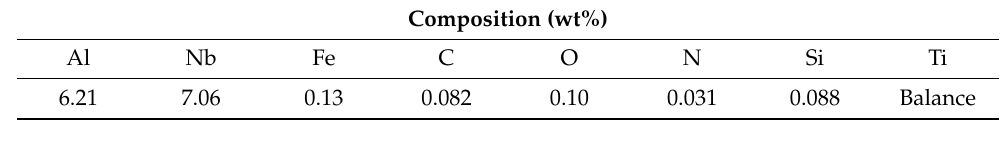
Table 1. Chemical composition of the Ti-6Al-7Nb alloy.